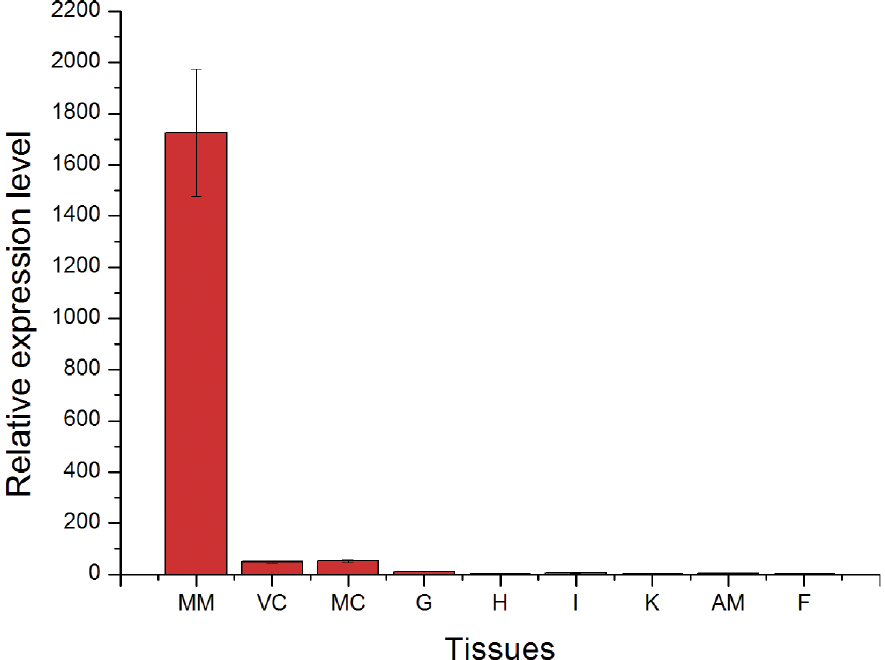
Fig 5. Tissue-specific expression of hic31 by qRT-PCR. MM, Marginal mantle; VC, velum craspedon; CM, Center mantle; G, gill; H, hepatopancres; I, Intestine; K, kidney; AM, adductor muscle; F,